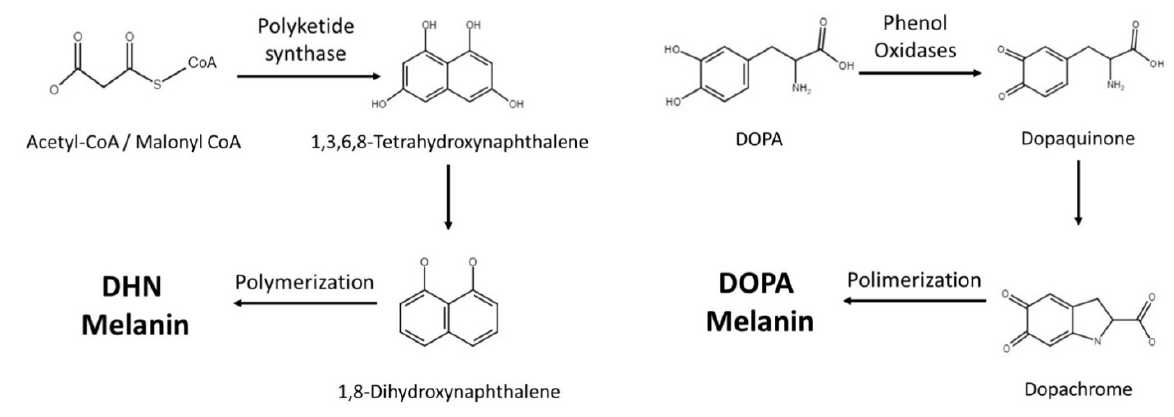
Figure 1. Current knowledge of melanin synthetic pathways in fungi. Table 1. Representative fungi and the types of melanin they produce [12–15].